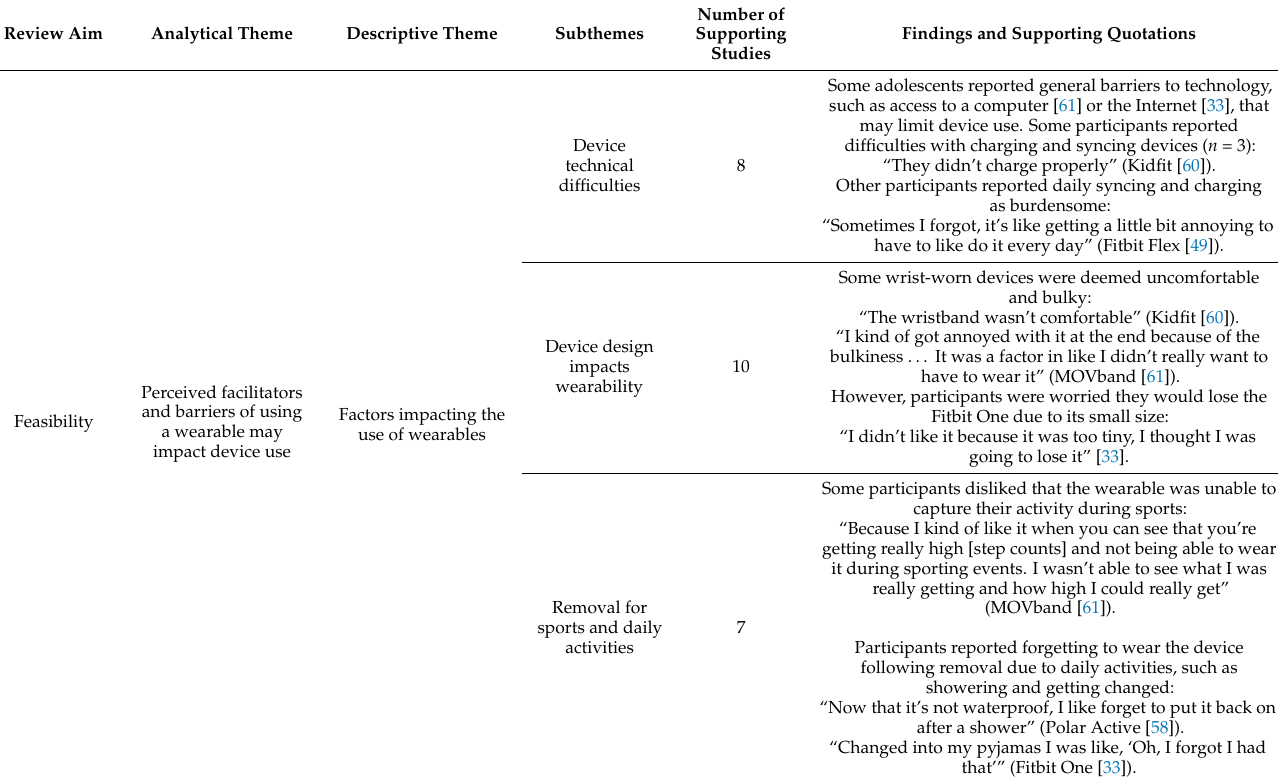
Table 4. Themes, findings, and supporting quotations identified in the thematic